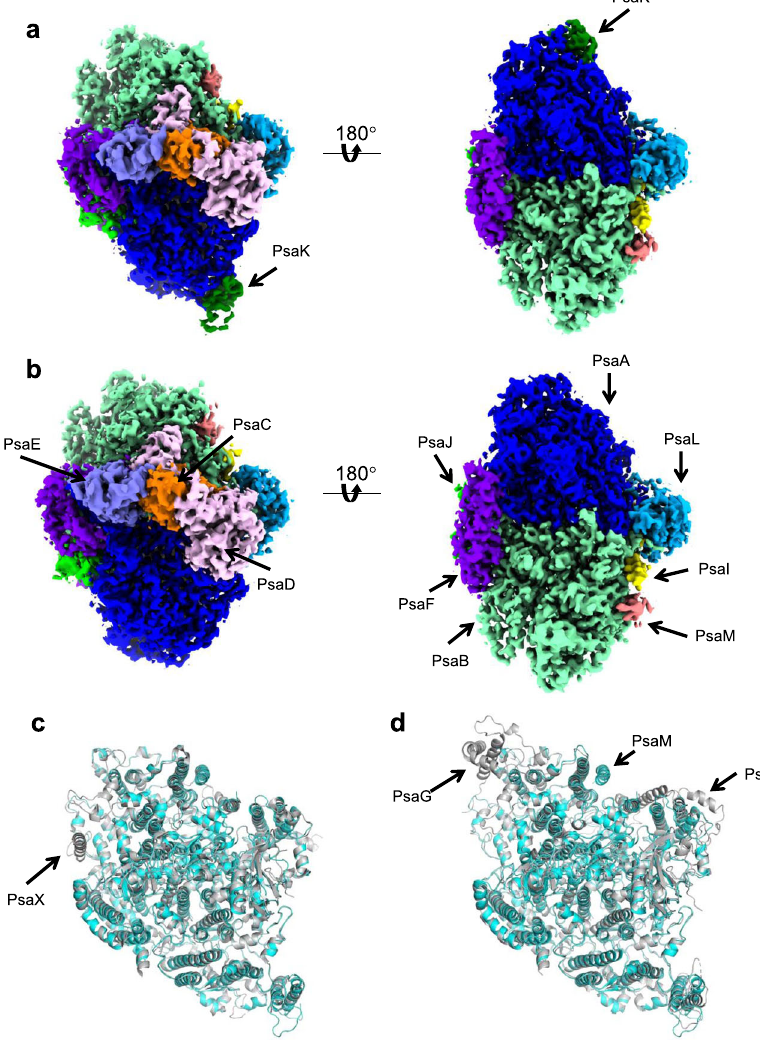
Fig. 2 Structure of the wild-type PSI monomers. a 3D map of monomer1 viewed along the membrane normal from the stromal (left) and lumenal (right) sides. b 3D map of monomer2 viewed along the membrane normal from the stromal (left) and lumenal (right) sides. c Superposition of the Cyanophora PSI monomer1 (cyan) with a PSI-monomer unit from T. elongatus (PDB: 1JB0) (gray), viewed along the membrane normal from the stromal side. d Superposition of the Cyanophora PSI monomer1 (cyan) with a PSI-monomer unit from P. sativum (PDB: 5L8R) (gray), viewed along the membrane normal from the stromal side. The subunits speci fi c to each organism are